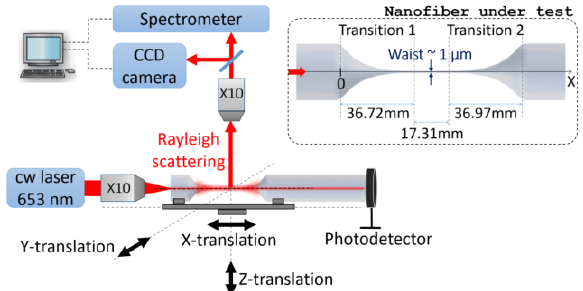
Fig. 1. Schematic experimental setup, and geometrical data of the ONF studied in this work (in dashed